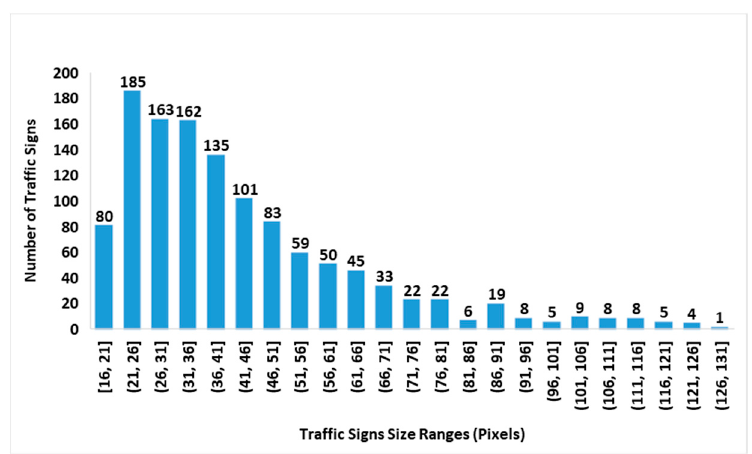
Figure 12. A histogram of the traffic sign size distribution in the Chinese traffic sign dataset (CTSD).